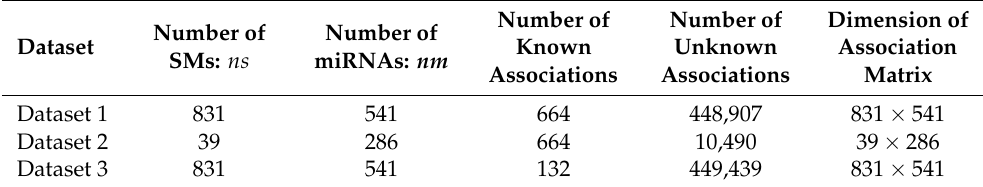
Table 2. The complete data information for three